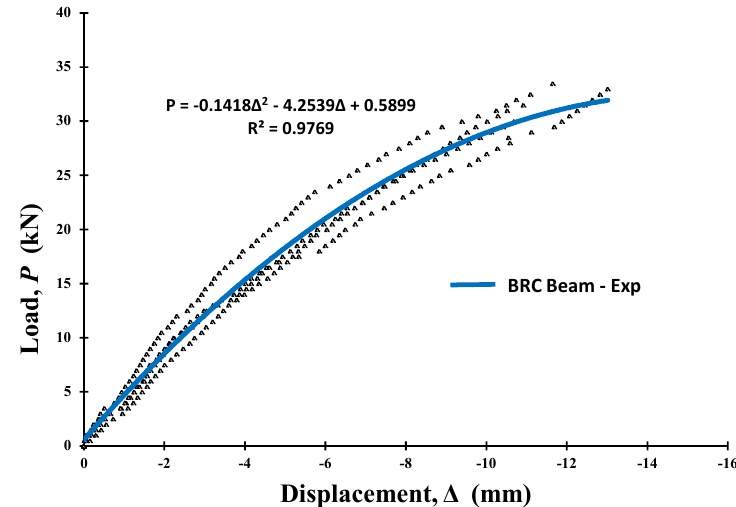
Figure 6. The relationship of load vs. displacement of BRC beam of experimental results.